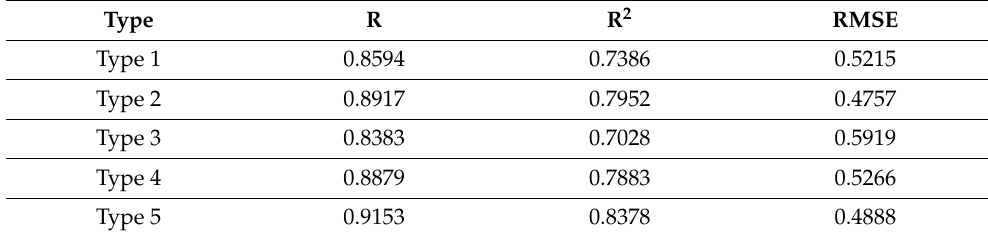
Table 7. Regression analysis results of equations for predicting the axial strain corresponding to the maximum compressive strength of the SMA-confined concrete cylindrical